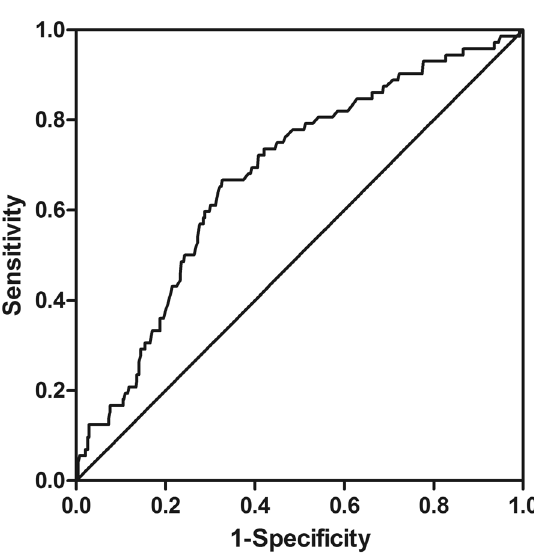
Figure 1. Receiver-operating characteristic curve (ROC) of UA predicting cardiovascular diseases clustering. ROC analysis yielded an optimal cutoff value of 352.5 μ mol/L (p < 0.001) for very elderly women. The area under the ROC curve was 0.677 (95%CI